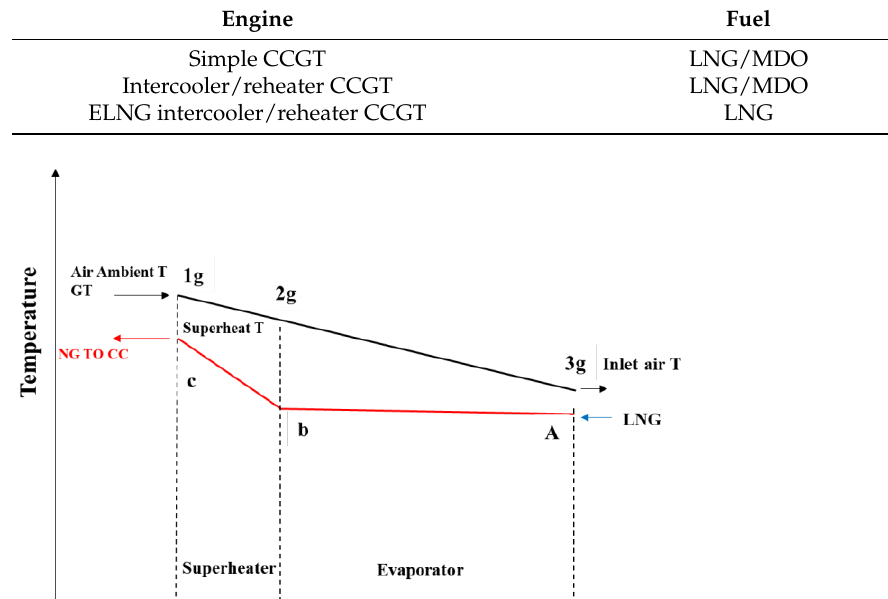
Figure 2. Heat balance in heat exchanger between the inlet air and LNG. 1g: inlet air mass flow temperature to heat exchanger; 2g: outlet air mass flow temperature from superheater stagnation to